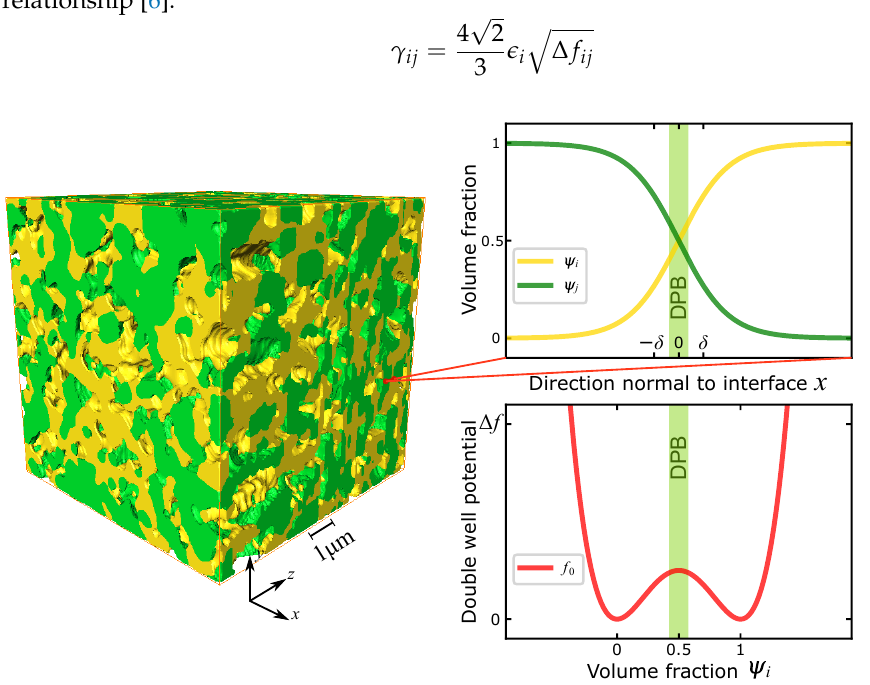
Figure 4. Diffuse interface (Double Phase Boundary—DPB) in a Phase Field